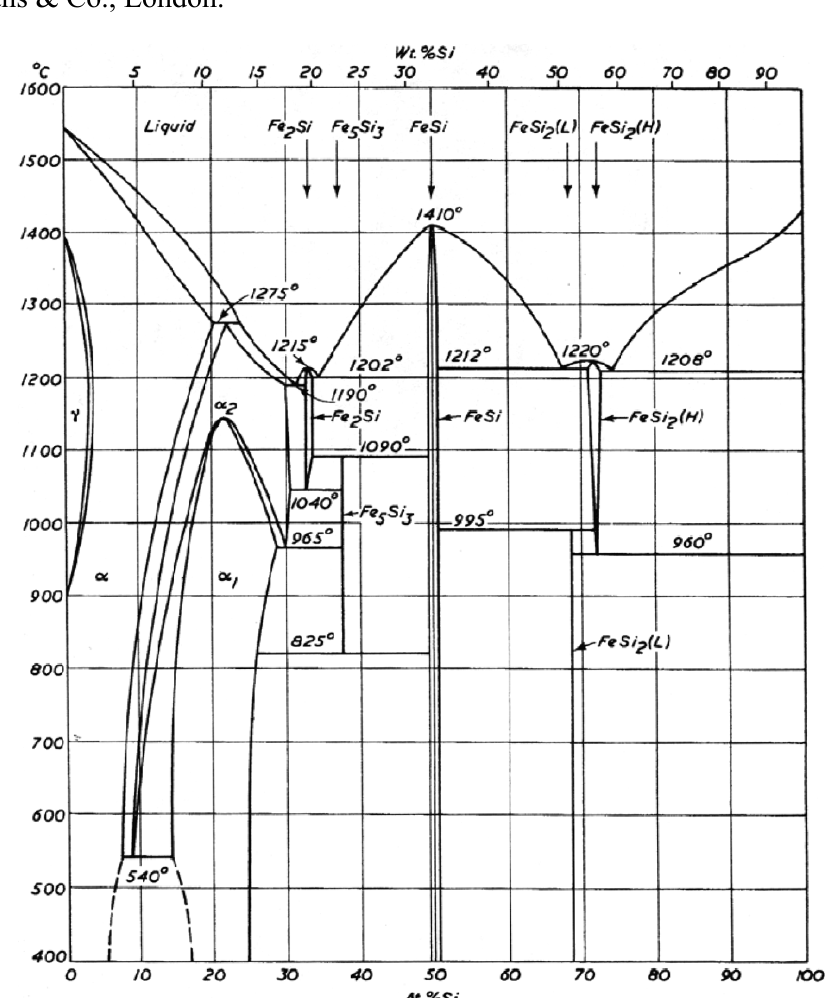
Figure 1. Fe-Si phase diagram. Reproduced from Ref. [12] with permission from Butterworths & Co.,